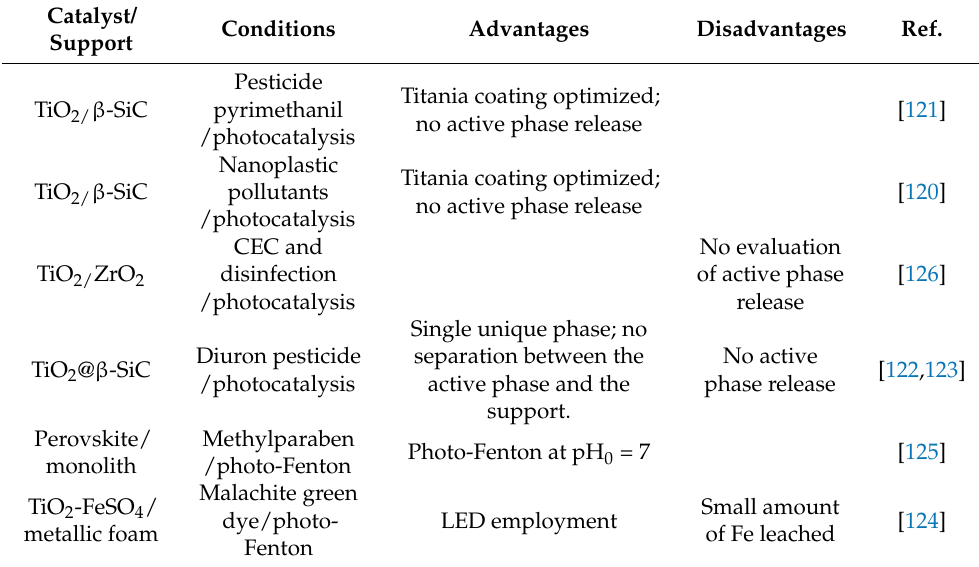
Table 9. Photocatalysts immobilised onto supports for water treatment of AOPs.